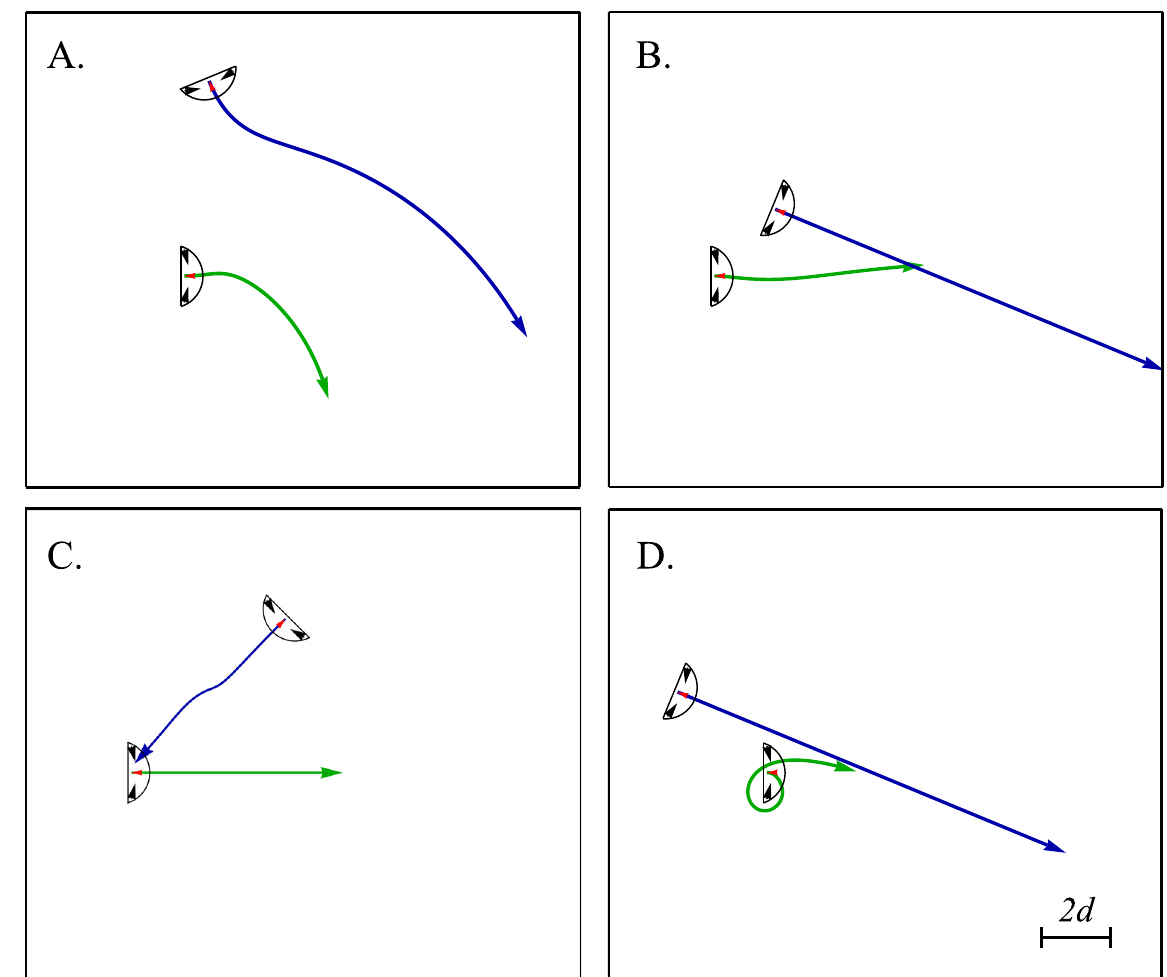
Fig 7. Non-identical cells: Examples of some effects that occur when the model cells properties are varied. Eq (10) is simulated with d = α = β = E = 1 (unless otherwise specified) and varying cell velocities, response to the elastic force and cells initial configurations. A. two cells that would collide approach one another at different speeds ( V 1 = 0.1, V 2 = 0.2, ξ 1 = ξ 2 = 1). B-D. One of the two cells does not react to the elastic force. B. The cell that does not respond to the interaction force moves faster ( V 1 = 0.025, V 2 = 0.05, ξ 1 = 0.05 = ξ 2 = 0, β 1,2 = 0.5) and the slow cell follows it. C. The two cells move at the same speed. The cells would move toward one another but do not collide without the interaction. ( V 1 = 0.05, V 2 = 0.05, ξ 1 = 0 = ξ 2 = 0.5, β 1,2 = 0.5) D. A slower cell makes a loop as a faster, unresponsive cell passes it ( V 1 = 0.025, V 2 = 0.05, ξ 1 = 1 = ξ 2 = 0). Movies of these simulations and of those obtained with other initial orientations are given in the Supporting